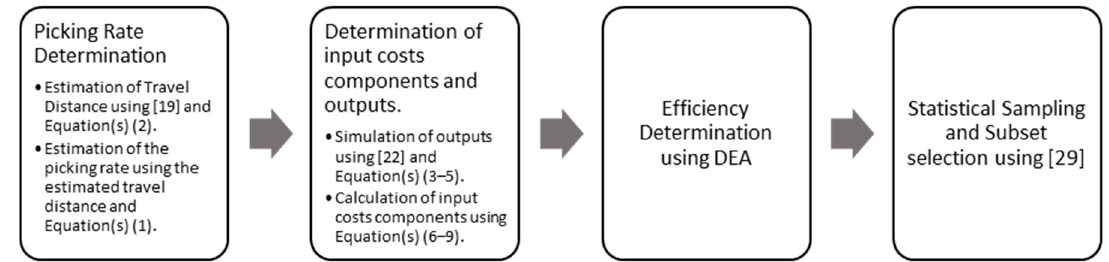
Figure 1. Flowchart of the methodological framework.